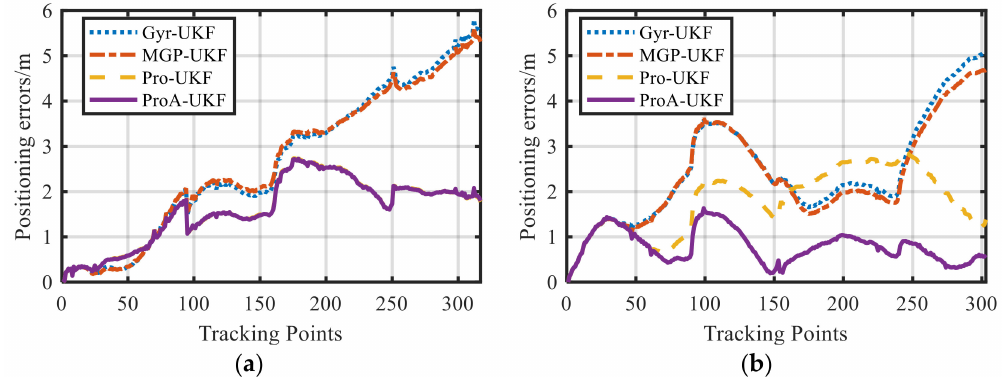
Figure 9. Position error of each step with di ff erent methods for di ff erent smartphones: ( a ) The position error of HV9; ( b ) The position error of